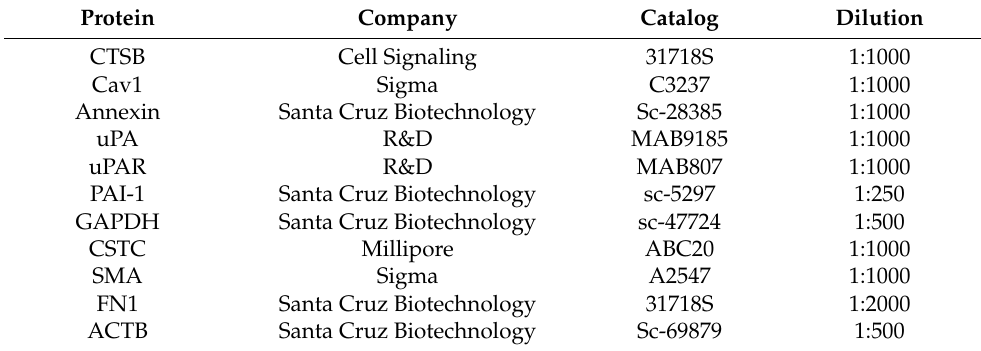
Table 1. List of antibodies and